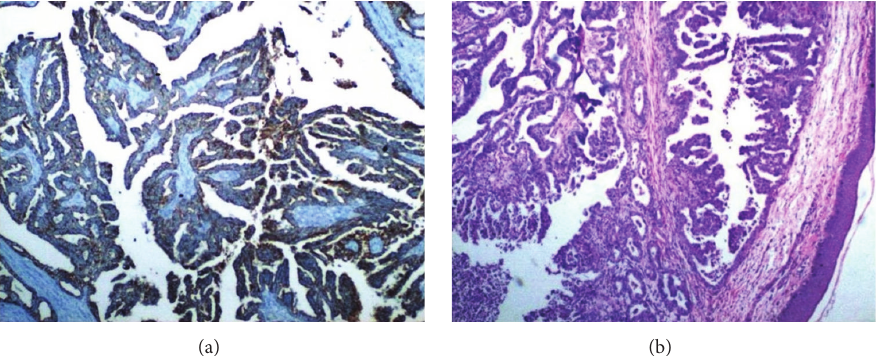
Figure 2: (a) Skin lesion demonstrating subcutaneous tissue with endometrial adenocarcinoma containing glandular structures. (b) Positive immunohistochemical expression with LMW-CK (low molecular weight